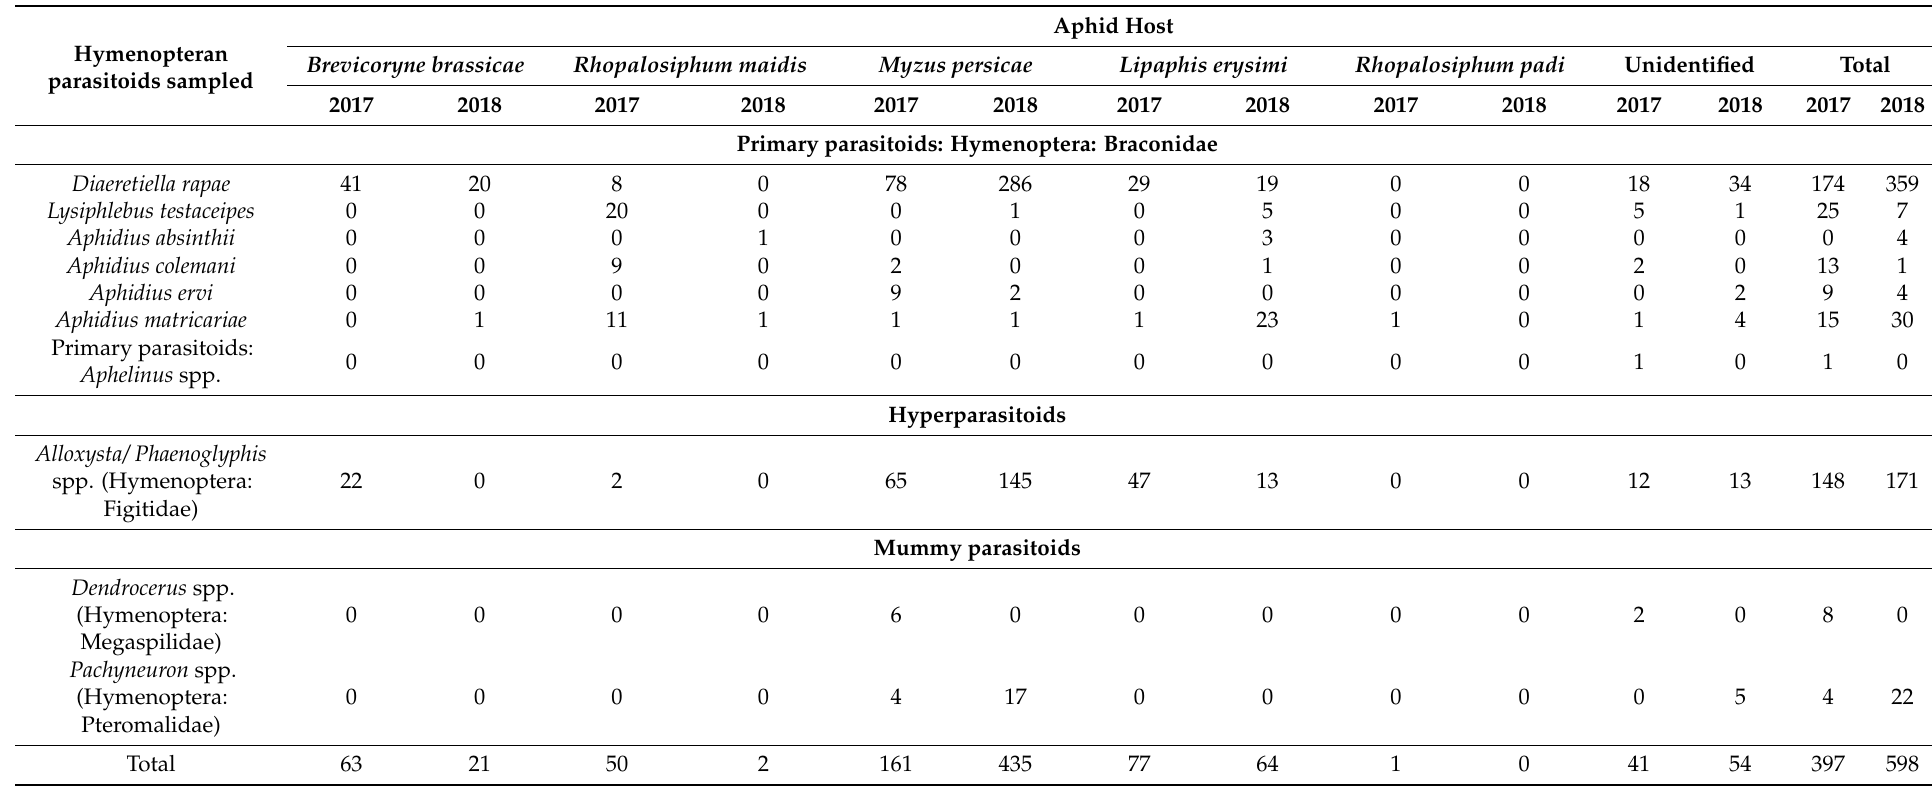
Table 1. Summary of parasitoids reared from mummies directly sampled for two minutes in 2017 and